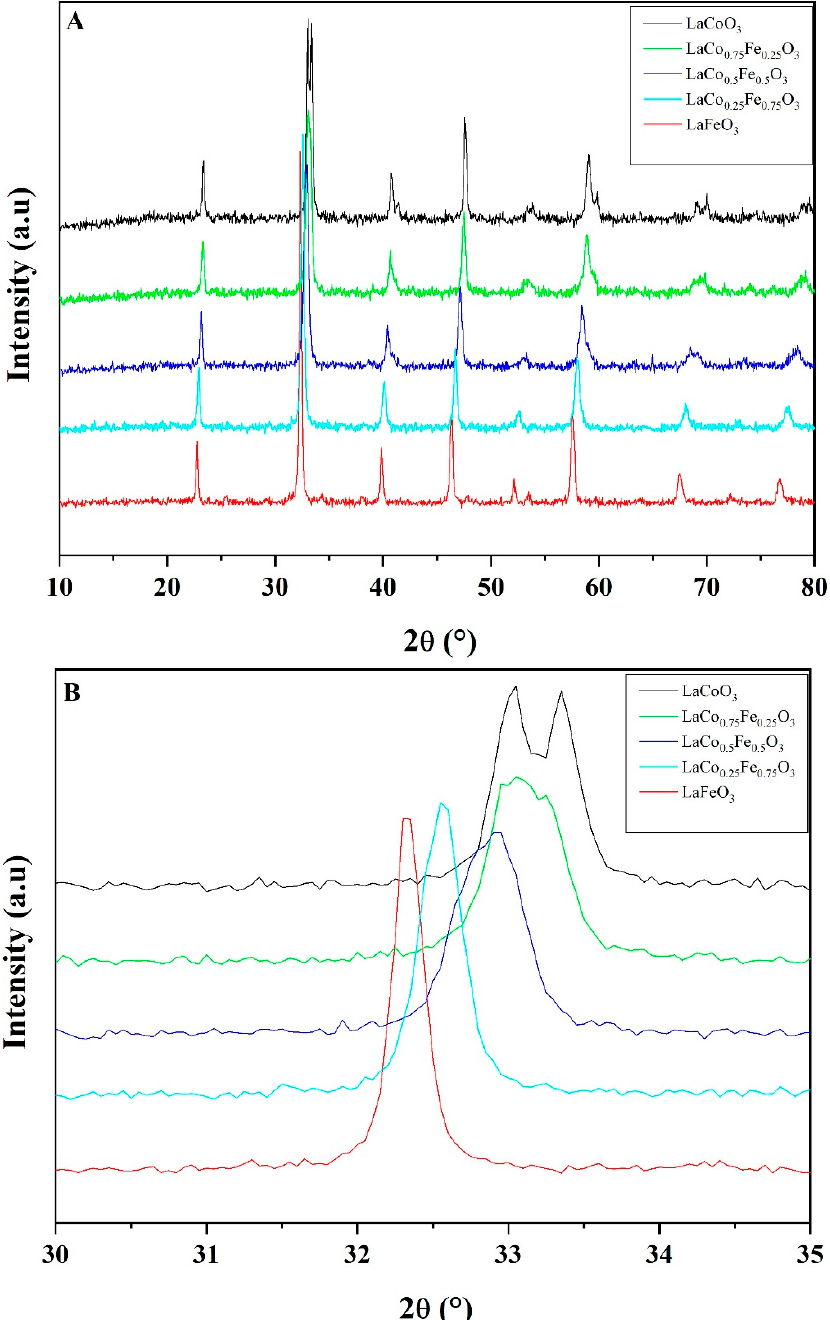
Figure 3. ( A ) Diffractograms of the synthesized catalysts. ( B ) Enlargement area of the main peaks. Table 3. Cell parameters of the synthesized structures.